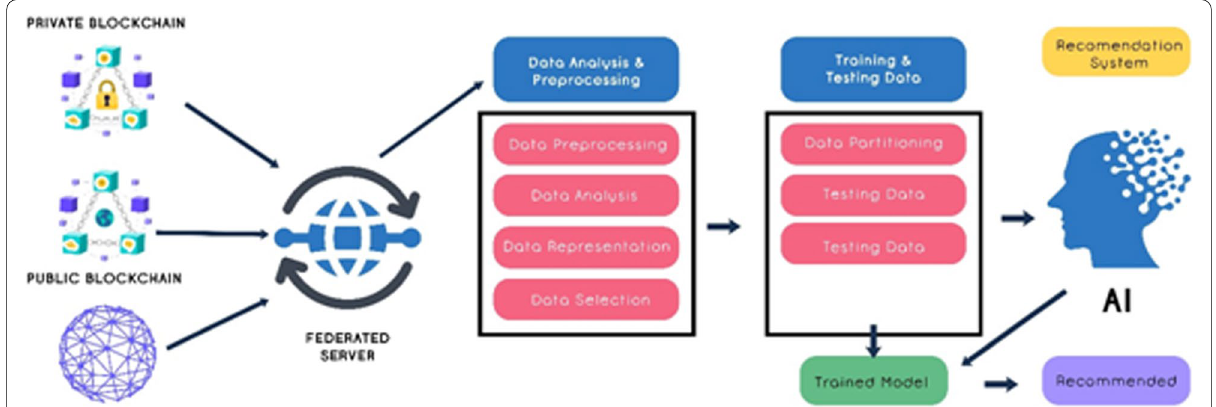
Fig. 2 Architecture of the proposed